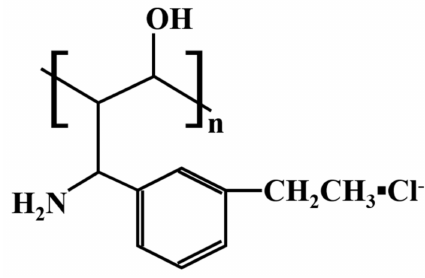
Figure 1. Schematic of SAIEF